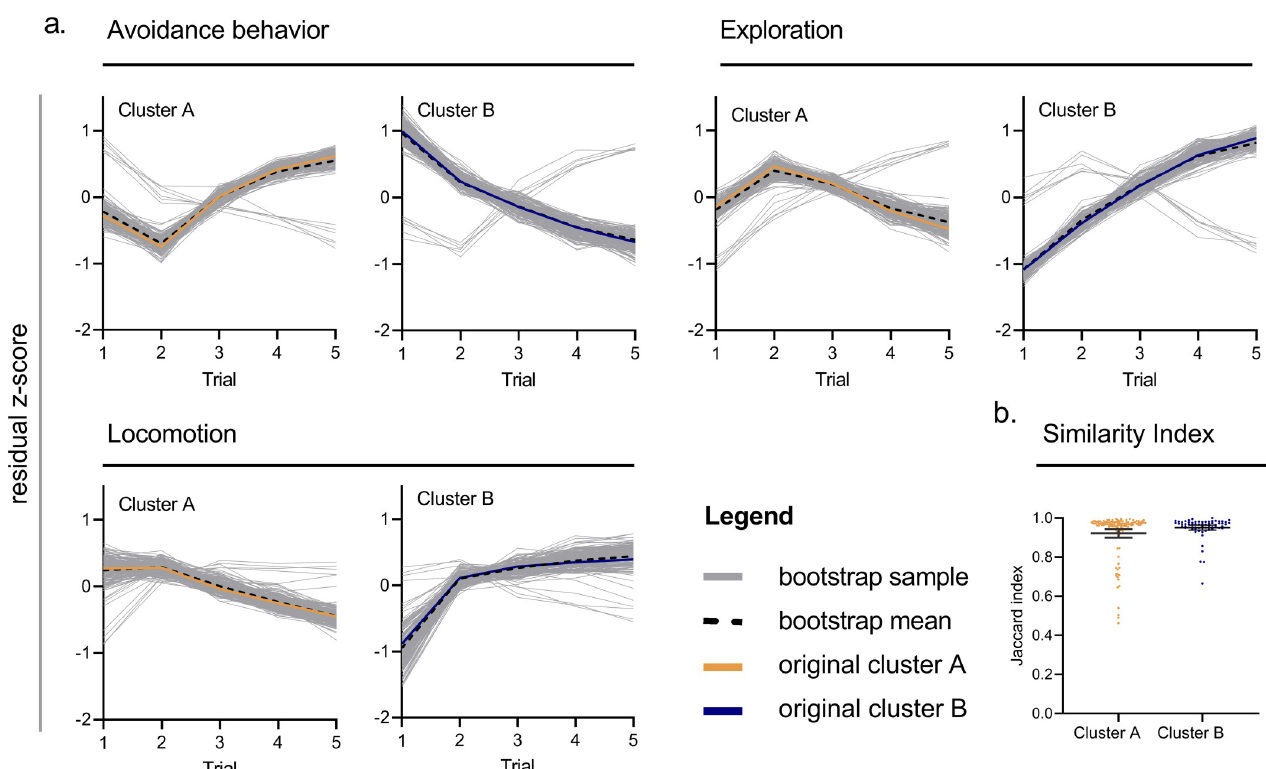
Fig 4. (a) Results of the bootstrapping procedure for each cluster, on each behavioral dimension. Results are presented as mean residual z-scores, and depict the trajectory of the original cluster (cluster A, orange; cluster B, blue) in relation to the average of all 200 bootstrap samples (black dashed line), against all 200 trajectories of the bootstrapping procedure (grey). (b) Distribution of individual Jaccard Indices in clusters A and B (cluster A, orange dots; cluster B, blue dots). Average Jaccard Index per cluster indicated by mean with 95% CI (black).